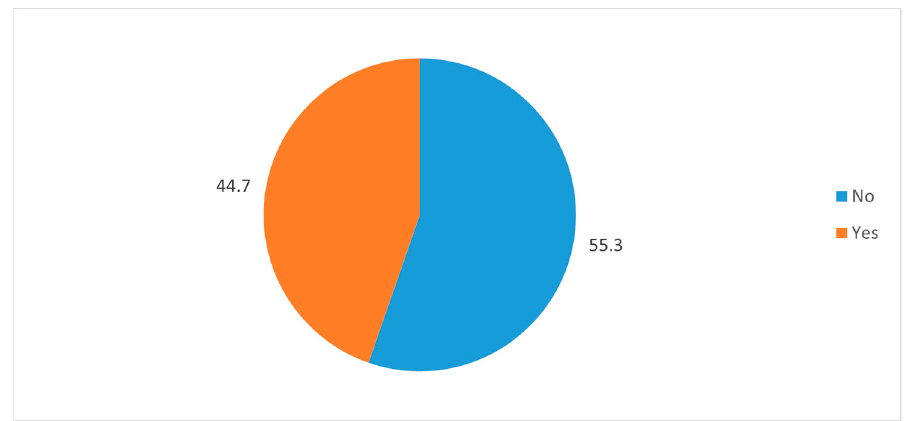
Figure 4. Pir chart reveals the distribution the respondents based on their response to the statement “would you be interested in taking an elective rotation in neurosurgery to get more exposure of the neurosurgery specialty?”.